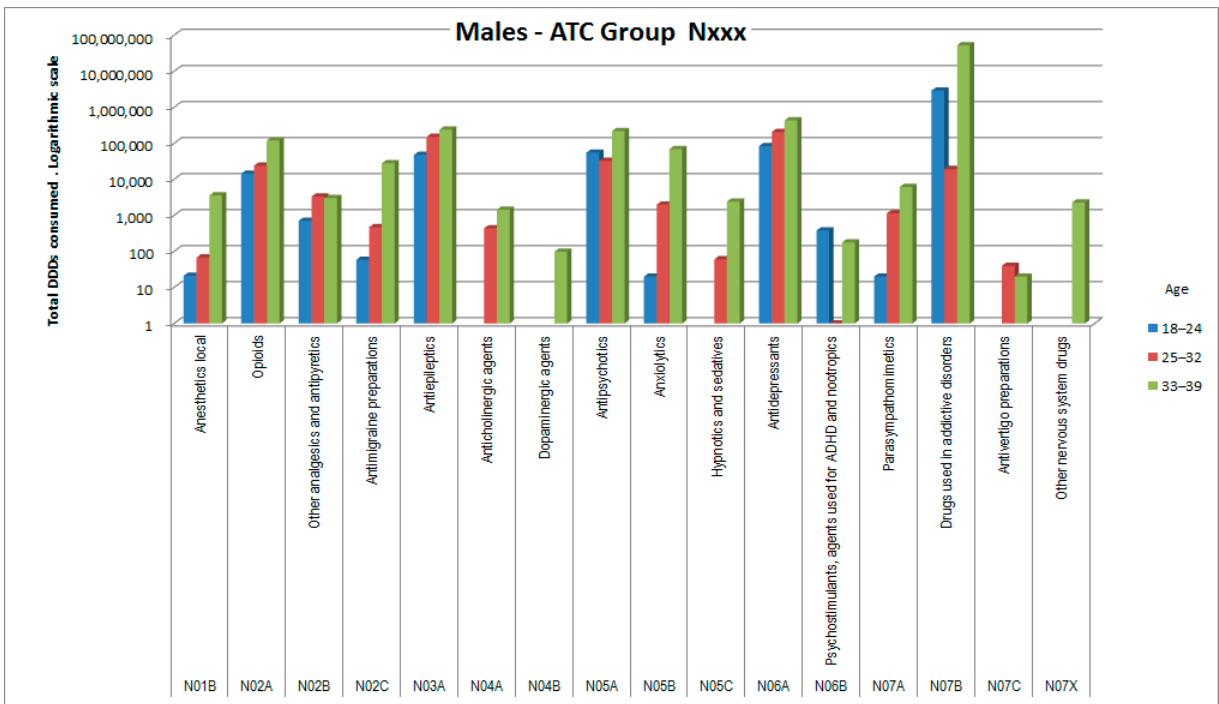
Figure 10. DDD consumption for males, ATC group Nxxx.